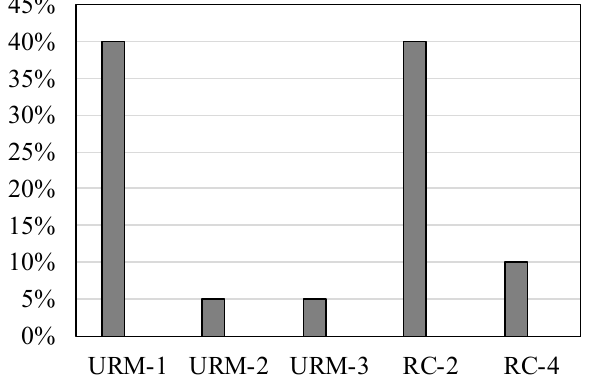
Figure 11. Percentage of building classes detected in Bargagli.